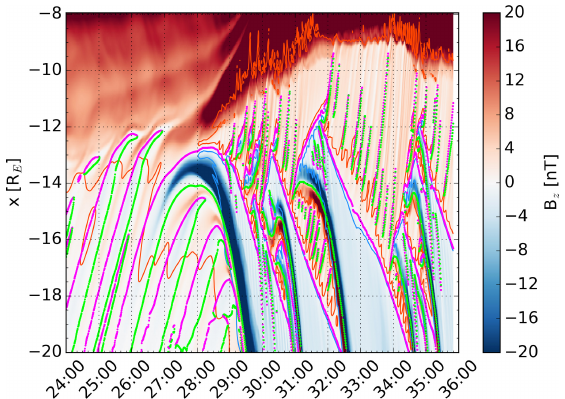
Figure 5. Duskward component ( V y , color) in the magnetotail plasma sheet ( y = z = 0) as a function of x and time in minutes after the beginning of the simulation (MM:SS). The ± 400kms − 1 contours are indicated with the orange and blue curves. Magenta and green dots show the locations of the X and O points, respec- tively.